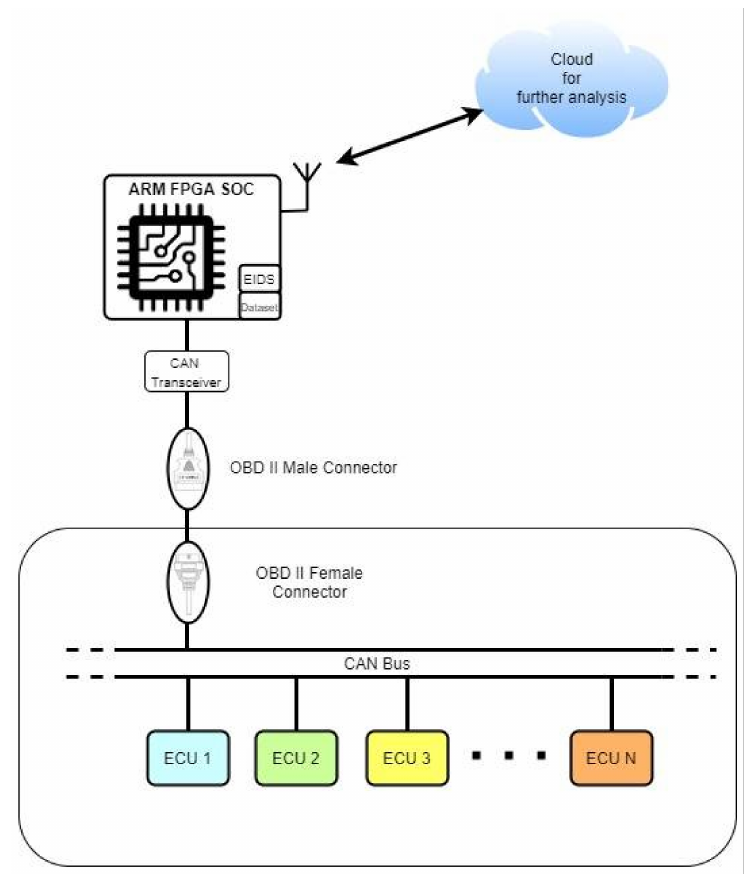
Figure 2. Proposed